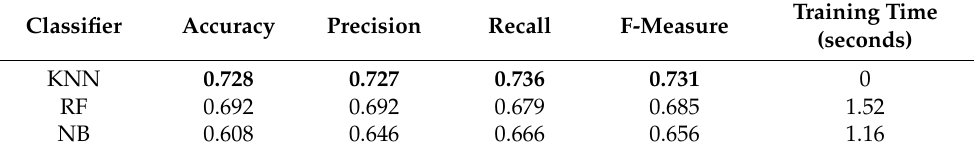
Table 4. Identification results of VGG-19-F7 deep features. Bold values signify the best performance.